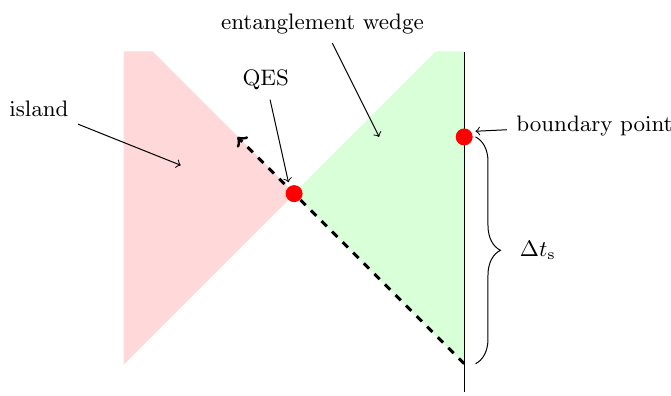
Figure 9 . The Hayden-Preskill protocol involves sending in a massless quantum into an old black hole (i.e. one with a QES) from the boundary at some time t 0 . The quantum leaves the entanglement wedge of the boundary (green) and enters the island (pink) precisely when the quantum passes through the QES. This (cid:12)xes the boundary time t of the QES. The di(cid:11)erence t (cid:0) t 0 is the scrambling time of the black hole (cid:1) t s